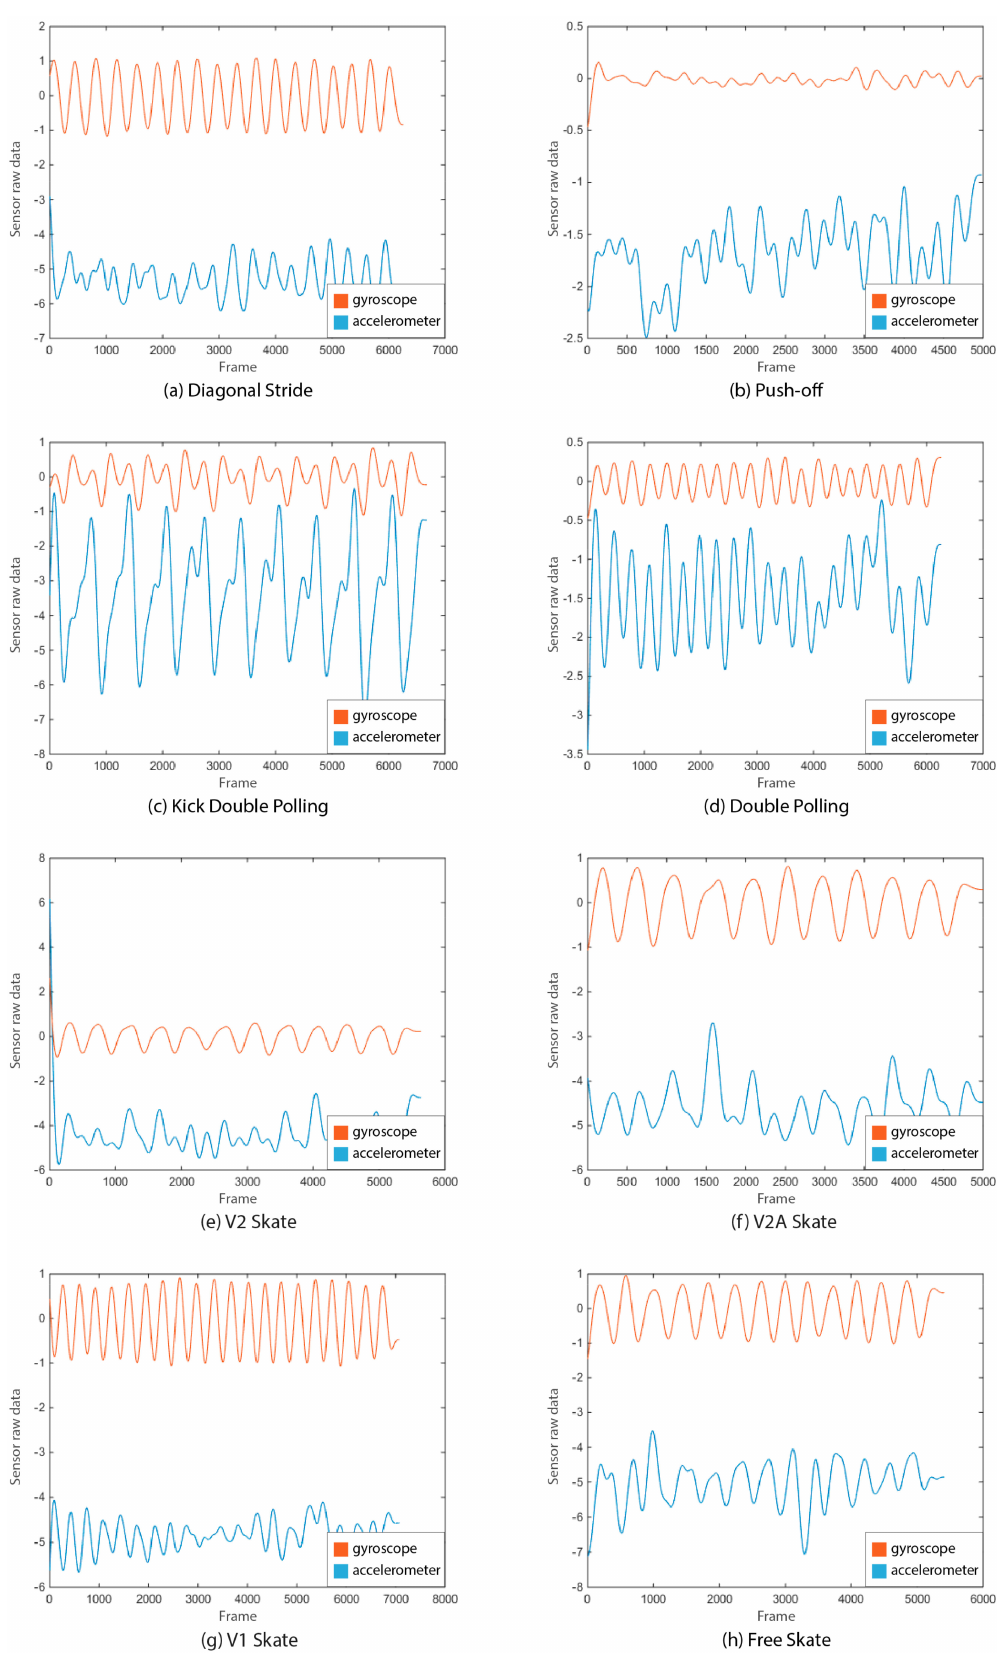
Figure 2. Comparison of the cyclic patterns in the z -axis (anteroposterior direction: normal to frontal plane) angular velocity and linear acceleration data (from a motion tracker on the flat surface of the shin bone of left leg) for the classical ( a – d ) and skating ( e – h ) XC- skiing